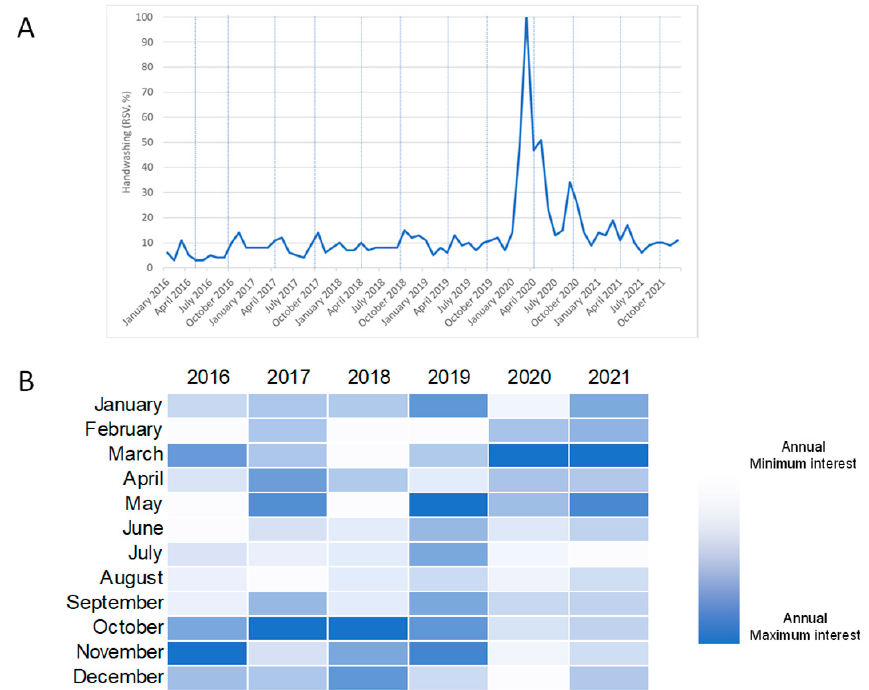
Figure 4. Public interest in the term “handwashing” based on Google Trends data. ( A ) Relative search volume over time from January 2016 to December 2021. Vertical blue lines correspond to the months when annual campaigns occurred; ( B ) heatmap showing the intensity of monthly public interest per year.